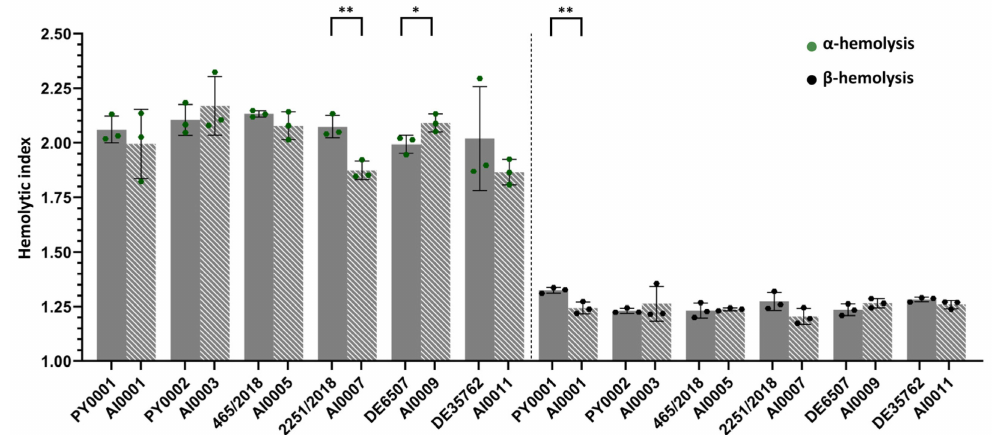
Figure 5. Hemolytic index. Bars show the mean results for the wild type S. ‘boulardii’ isolates (full grey) and for the ∆∆ HMX1 mutant strains (striped). Individual data points are shown in green ( α -hemolysis) and black ( β -hemolysis), and whiskers show the standard deviation of the data. Comparisons with significant differences are marked (*: p < 0.05; **: p <